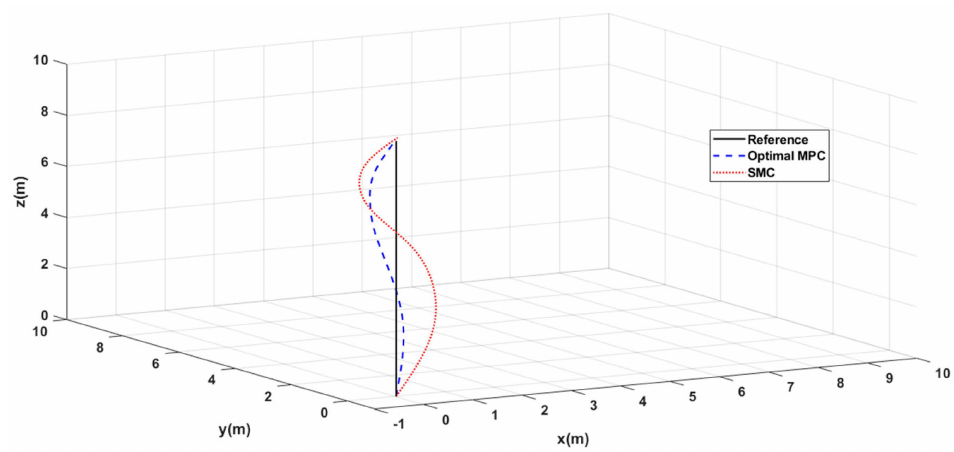
Figure 1. The result of applying the proposed control method and SMC method [50] to the helicopter in the first scenario.